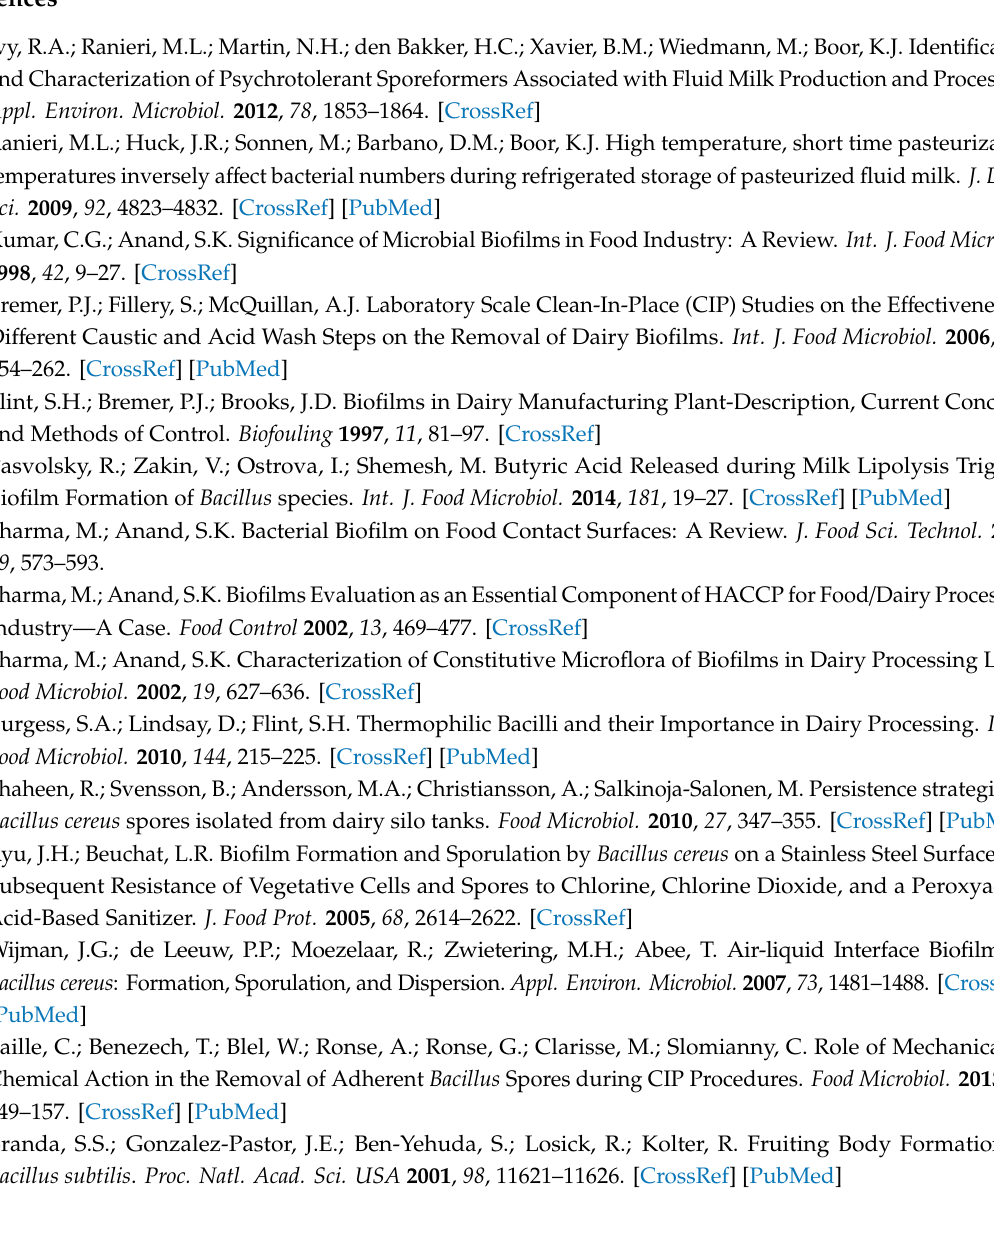
Figure S1: E ff ect of the cleaning procedure with tap water on removal of the biofilm-derived spores of the dairy-associated Bacillus in the simplified laboratory system, Figure S2: Chemo-biological e ff ect of the commercial cleaning agents on removal of the biofilm derived spores in the laboratory CIP system, Figure S3: Correlation between mechanical and chemo-biological e ff ect of the examined agents in relation to the removal of the biofilm derived spores in the laboratory CIP system, Table S1: Relative quantity of the matrix, surrounding biofilm-derived spores of the dairy-associated Bacillus isolates and B. subtilis